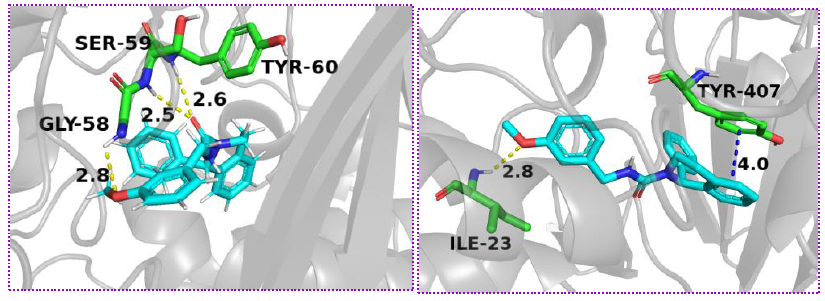
Figure 6. Docking result of 2t and MAO-A ( left ), MAO-B ( right ) (PDB:2Z5X).